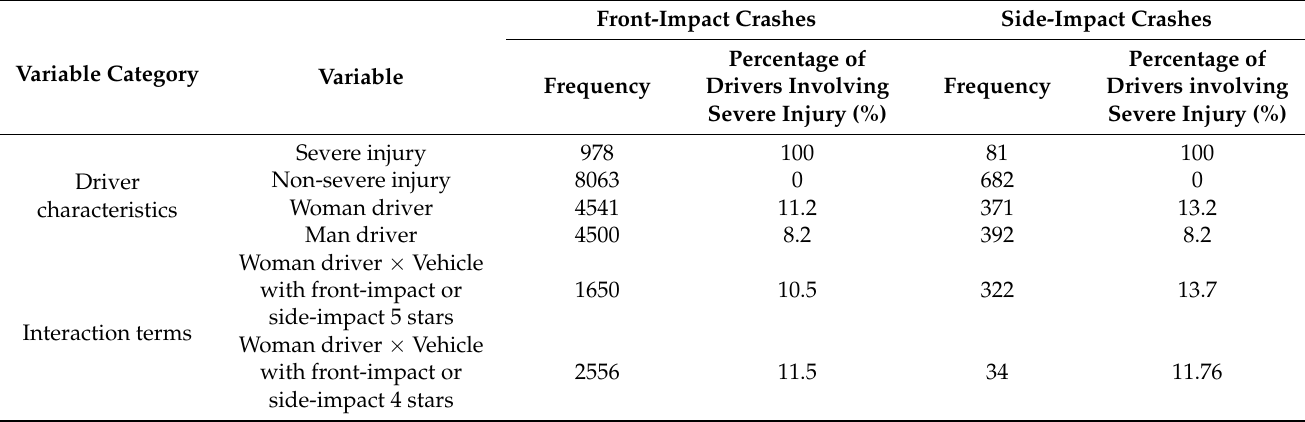
Table 2. Descriptive statistics of the key data including front-impact and side-impact